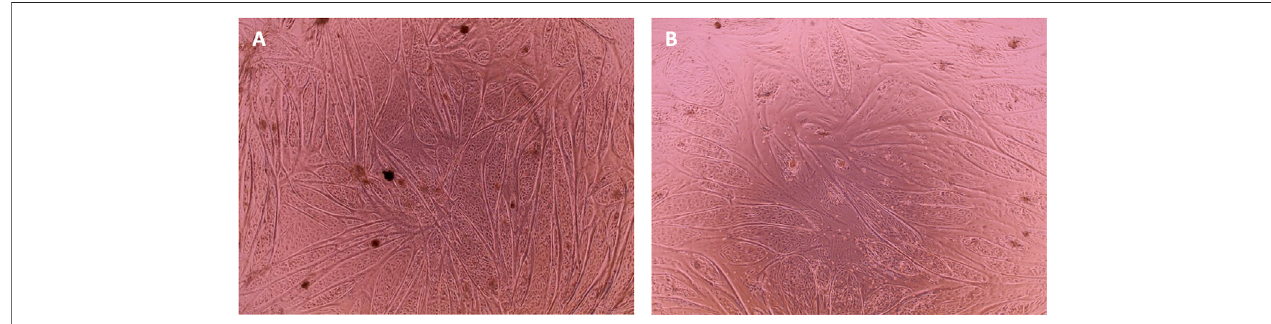
FIGURE8| Phasecontrastmicroscopyimagesofcelldifferentiationcultureatday7ofdifferentiation.CellsfromISO44 (A) andISO45 (B) thatweregrowinginSFM were seeded for differentiation at — 16 population doublings. After 24 h in SFM, and when the cells reached a 90% con fl uency, differentiation was induced with DMEM (1 g/L glucose) + 2%